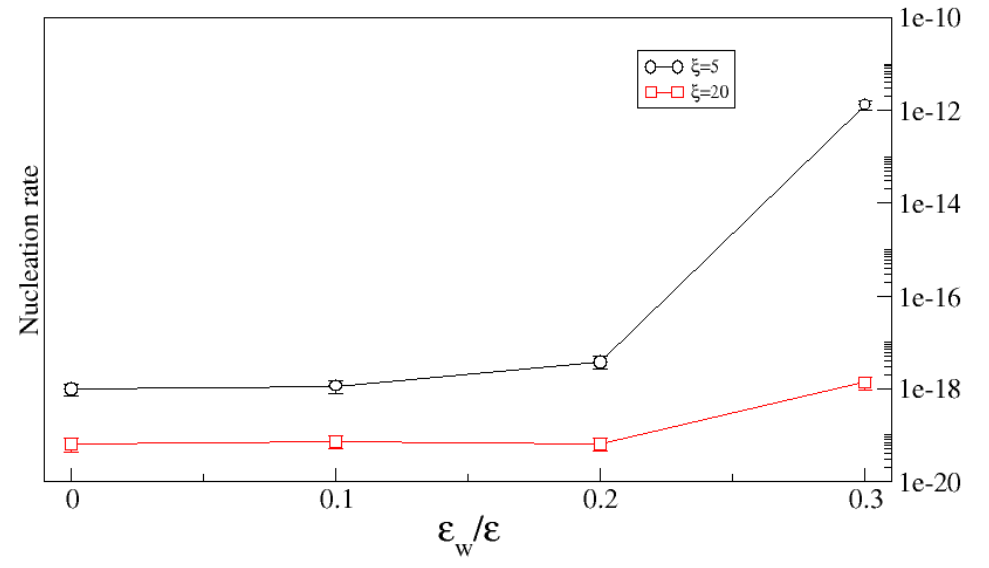
= a 2 / D ) as a function the binding energy (cid:101) 0